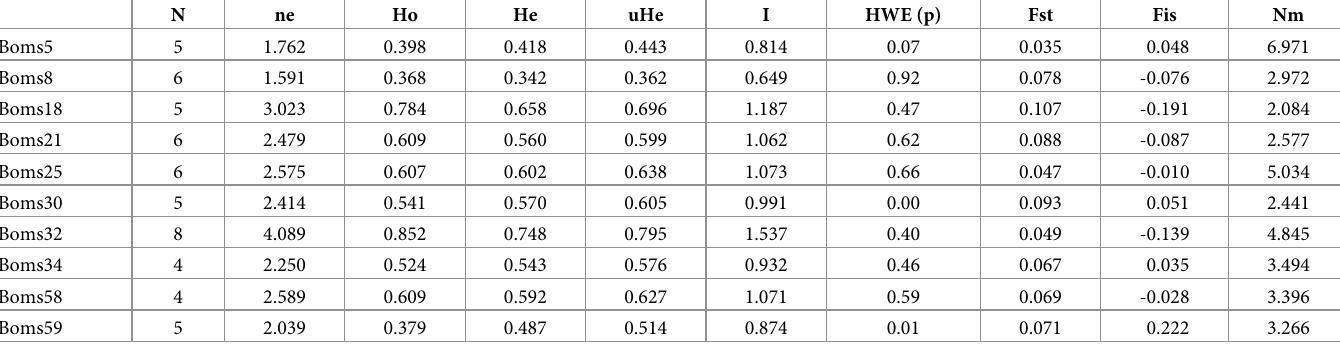
Table 4. Parameters of genetic variability: Number of alleles (n), number of effective alleles (ne), observed heterozygosity (Ho), expected heterozygosity (He), Unbi- ased Expected heterozygosity (uHe), information index (I), Hardy–Weinberg equilibrium (HWE), fixation index (Fst) and inbreeding coefficient (FIS) and gene flow (Nm) among sampling